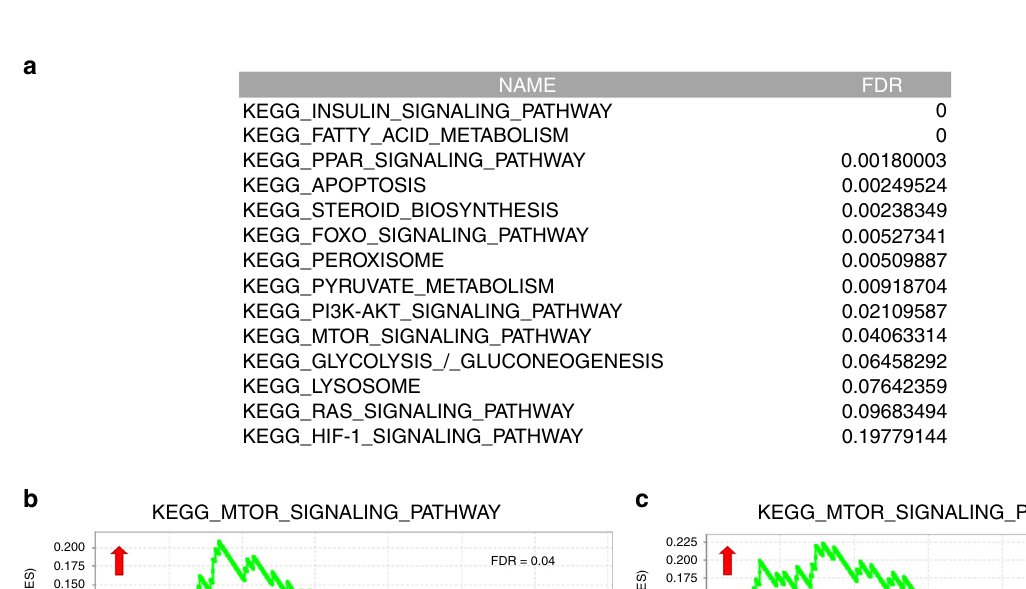
Fig. 4 Worsened mitochondrial function in rapamycin-treated wild-type mice. a Western blot representative images (left panel) and quanti fi cation (right panel) of LC3 protein levels, LC3-I and LC3-II forms (LC3-II/LC3-I ratio), and tubulin as a loading control from hepatic protein extracts from healthy male Terc + / + and G2 Terc − / − mice fed rapamycin or control diet during 2 months. b , c Mitochondrial DNA copy number as de fi ned by analysis of the Cyt-b and Nd1 mitochondrial genes in liver ( b ) and skeletal muscle ( c ) from rapamycin or control fed Terc + / + and G2 Terc − / − mice at the HEP. d Western blot representative images (upper panel) and quanti fi cation (lower panel) of the OXPHOS complexes V (ATP5A), III (UQCRC2), IV (MTCO1), and II (SDHB) protein levels in liver from rapamycin- or control-fed Terc + / + and G2 Terc − / − mice at the HEP. Error bars represent the SE. n = number of mice. Statistical signi fi cance was determined by one-way Anova with post hoc Tukey test. * p ≤ 0.05; ** p ≤ 0.01; *** p ≤ 0.001; n.s. not signi fi cant. Source data are provided as a Source Data fi le.